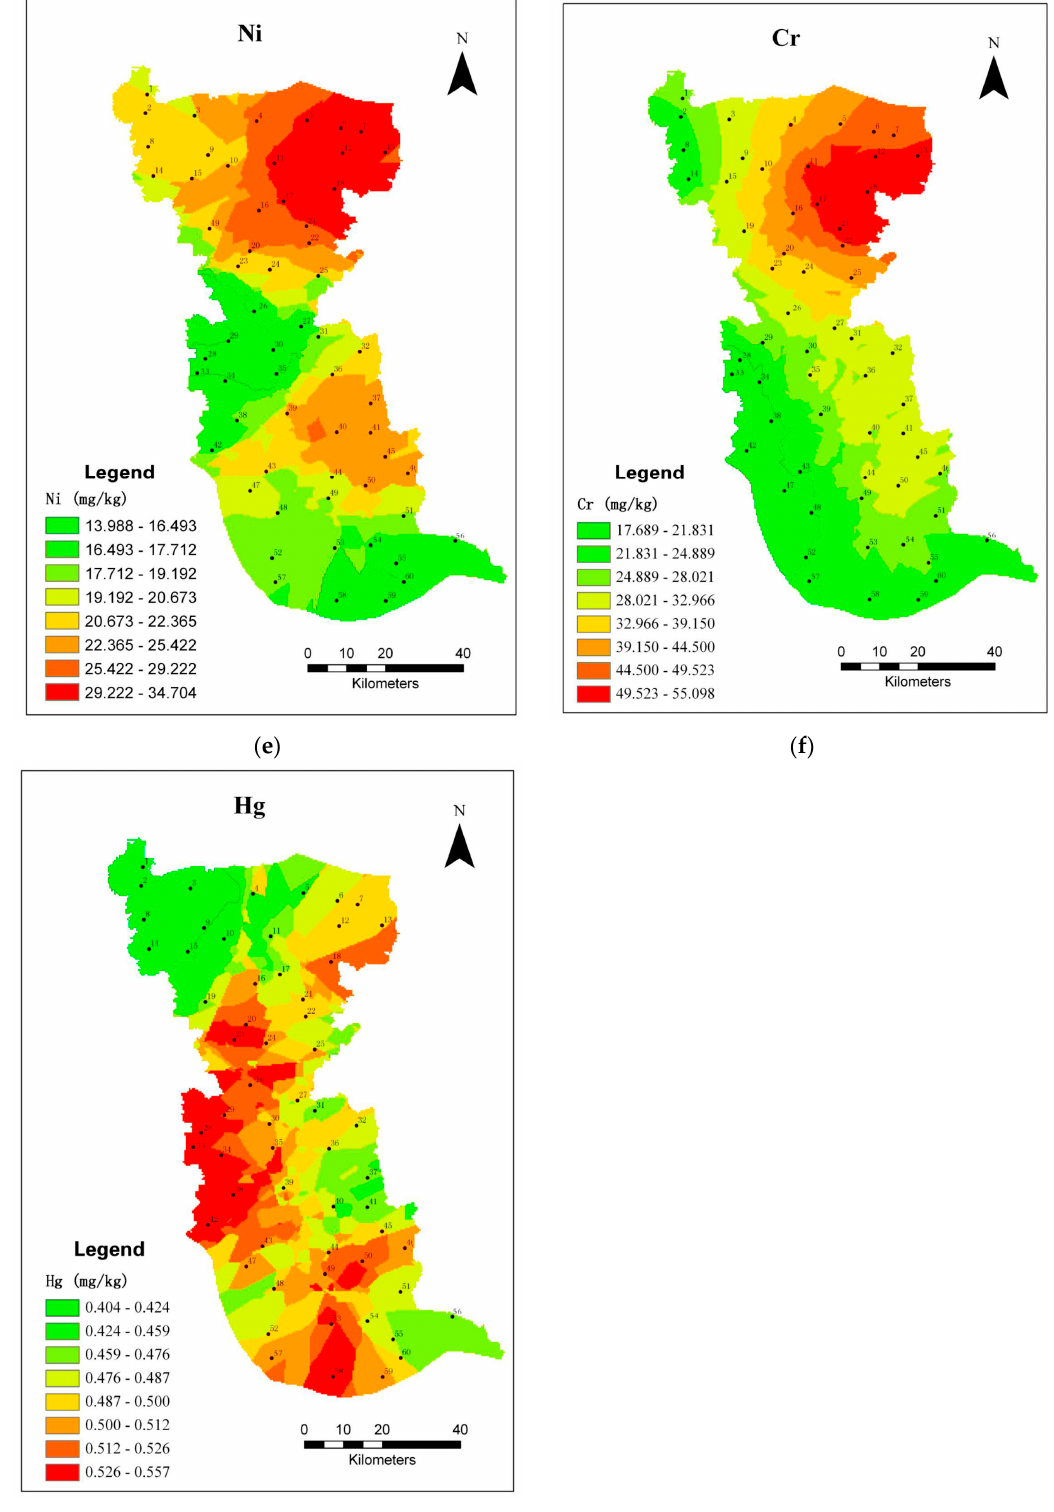
Figure 2. GIS maps of airborne trace metal deposition in Taizhou. ( a ) Distribution of Cd; ( b ) Distribution of Cu; ( c ) Distribution of Pb; ( d ) Distribution of Zn; ( e ) Distribution of Ni; ( f ) Distribution of Cr; ( g ) Distribution of Hg.